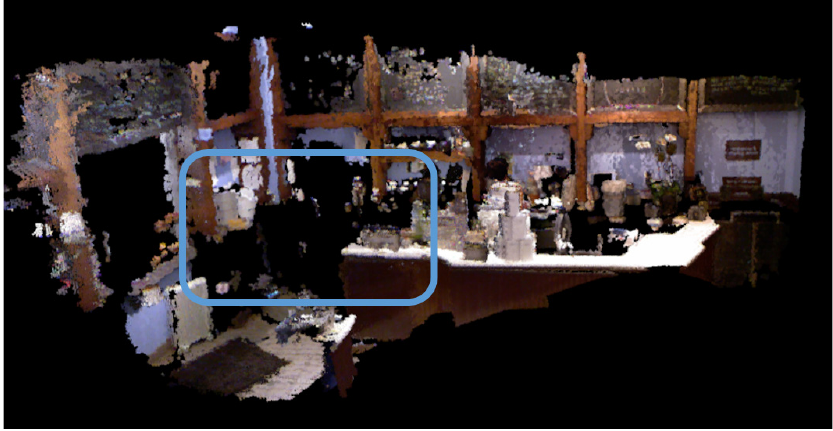
Figure 12. Static map of dynamic